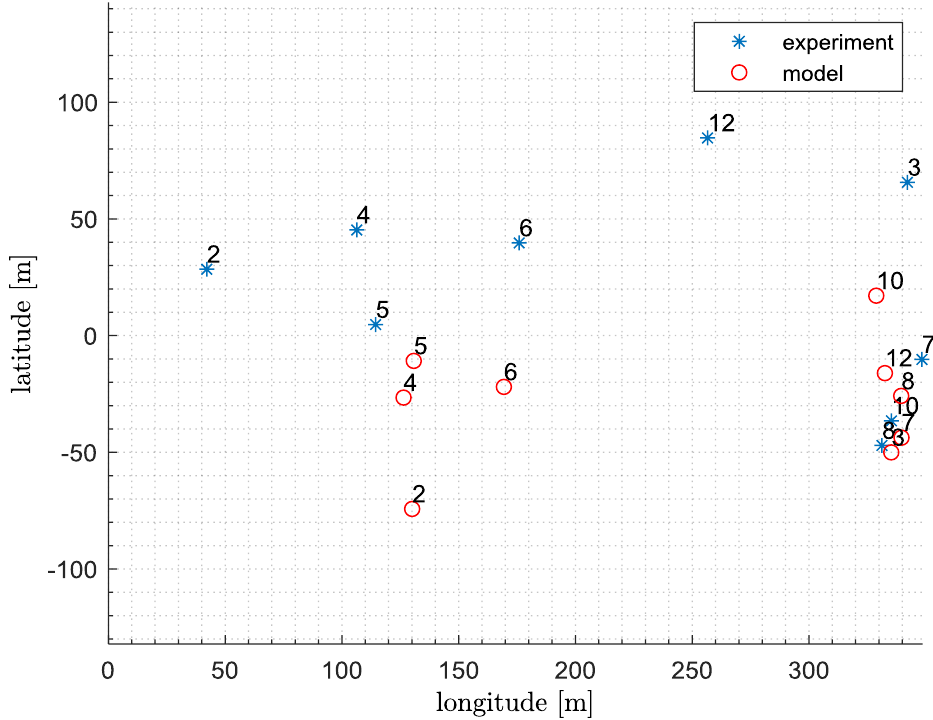
Figure 29. Displacements at parachute deployment (origin of the coordinate frame centered at launcher location in the first phase of tests, positive latitude to the north, positive longitude to the east).